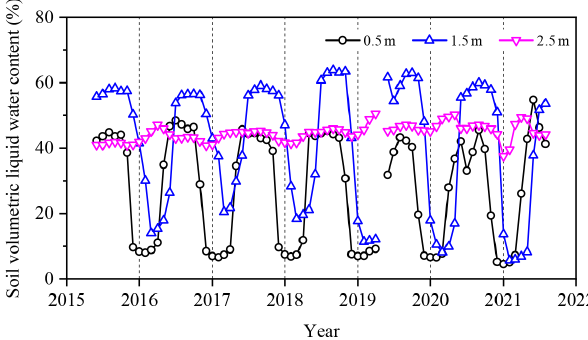
Figure 10. Temporal history of soil volumetric liquid water con- tent (VWC) at depths of 0.5, 1.5 and 2.5m at the JB site along the China–Russia Crude Oil Pipeline (CRCOP) I in the northern part of Northeast China during